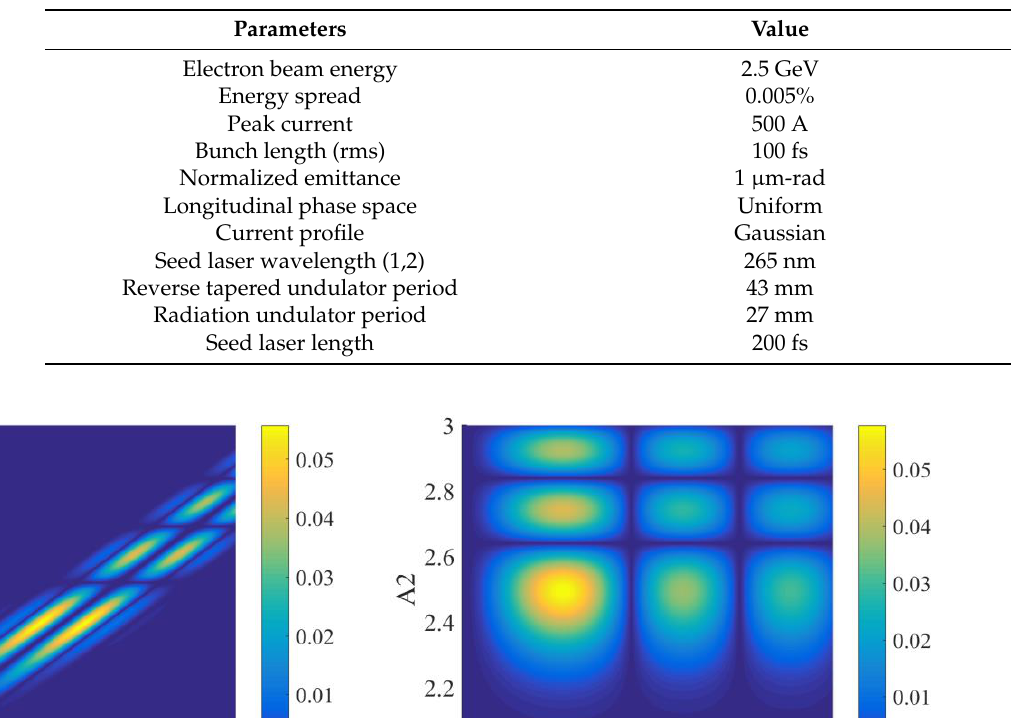
Table 1. Main parameters of a soft x-ray free-electron lasers (FEL) facility.